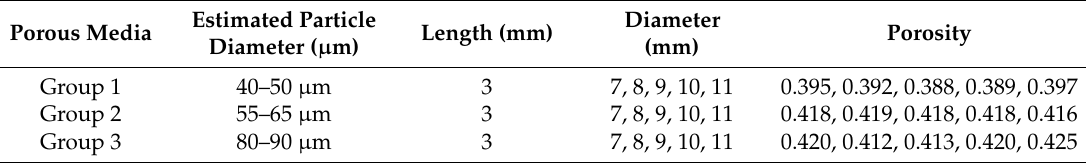
Table 2. Properties of the test porous media in this